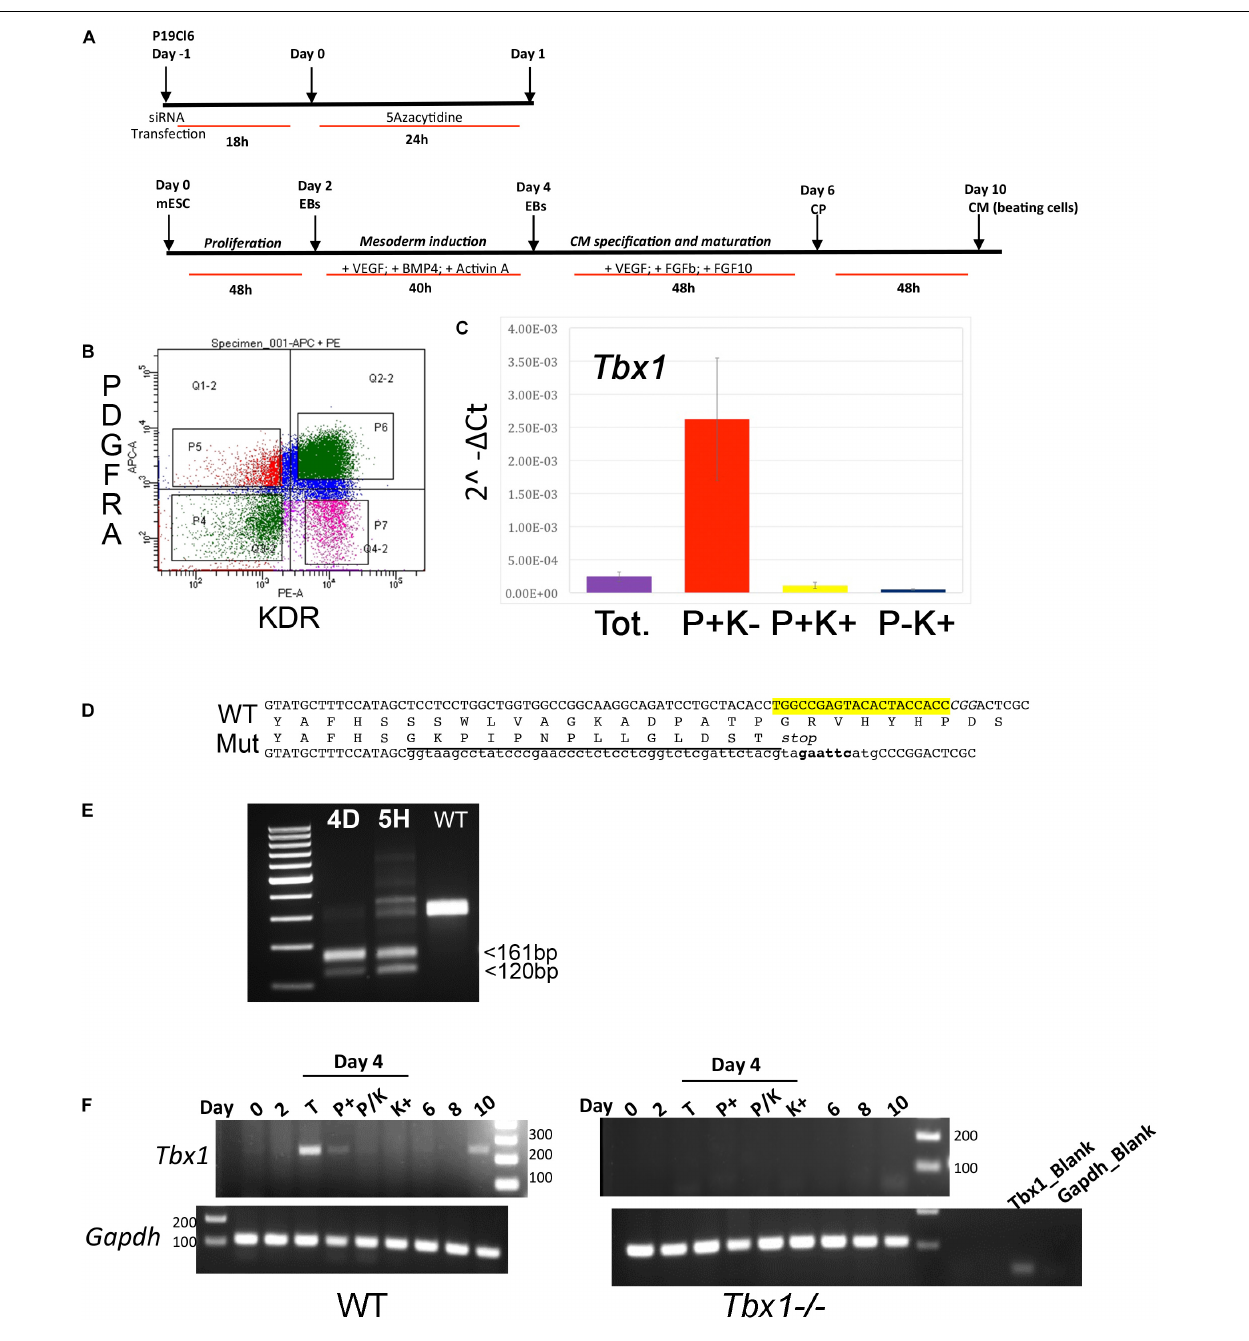
FIGURE 1 | Experimental protocols and reagents used in this study. (A) Top: differentiation protocols for P19Cl6 cells, transfected with Tbx1 -targeted or non-targeted siRNA. Cells were assayed at day 1 of differentiation. Bottom: differentiation protocol used for mES cells. Cells were assayed at day 4. (B) Representative plot of the gating strategy used for immunophenotyping of cells during mES differentiation. The PDGFRA+; KDR–, PDGFRA+; KDR+, PDGFRA–; KDR+ subpopulations were identified at day 4 of differentiation by FACS using anti-PGFRA and anti-KDR antibodies. (C) Quantitative real time PCR. Tbx1 expression was evaluated in the three subpopulations and in unsorted cells (Tot.). P, PDGFRA; K, KDR. (D) Strategy to generate a knockout allele of Tbx1 using CRISPR-Cas9 and homologous recombination. The top line shows the WT sequence of ex 3/7 (or 5/9). In yellow, the gRNA sequence; in italic the PAM sequence, CGG. The two intermediate lines indicate the predicted amino acid sequences. The bottom line indicates the sequence of the recombinant allele. WT sequence is shown in uppercase; the sequence inserted by homologous recombination is shown in lowercase, this includes a V5 tag (underlined), a stop codon, and a diagnostic Eco RI digestion site (in bold). (E) PCR amplification of the targeted region from Tbx1 homozygous clones 4D and 5H, and from WT digested with Eco RI. (F) Tbx1 expression revealed by reverse transcription PCR. Left panel: PCR of samples collected at the differentiation stages indicated on WT mES cells. At day 4, the analysis was performed on total populations (T) and on FACS-purified subpopulations. The right panel shows the same experiment performed using the Tbx1 − / − clone 5H. P, PDGFRA; K, KDR.